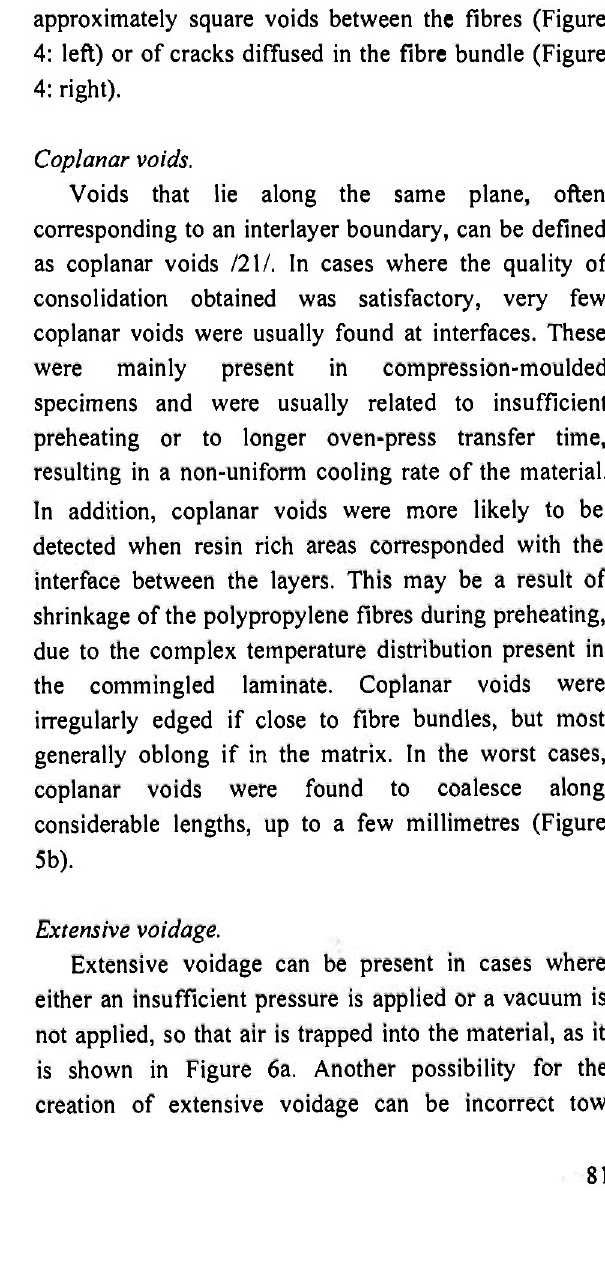
4: left) or of cracks diffused in the fibre bundle (Figure 4: